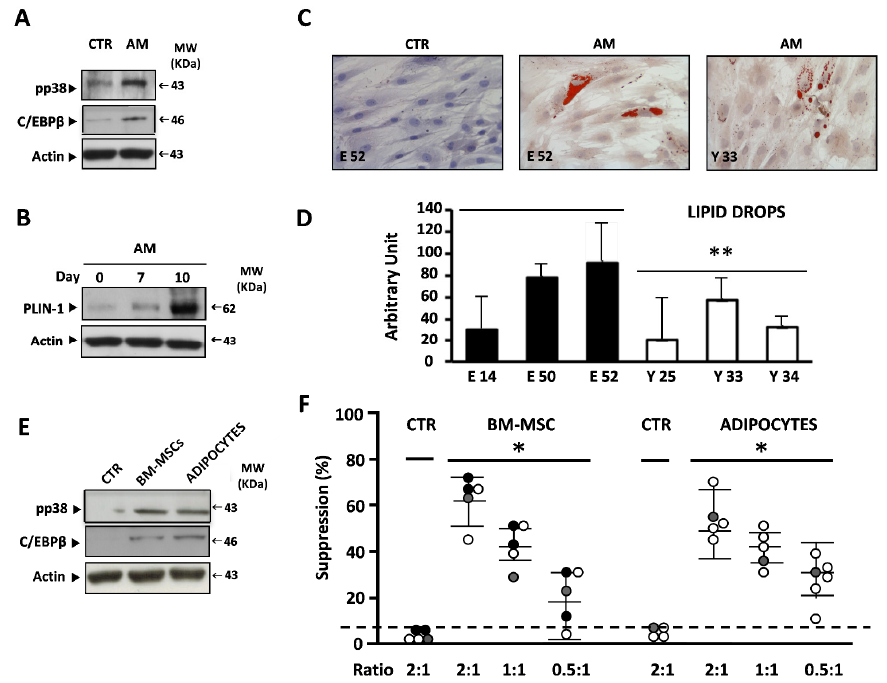
Figure 3. BM-MSCs or BM-MSC-derived adipocytes efficiently induce the suppressive activity of I-MDSCs. ( A ). Representative immunoblotting analysis of p38 MAPK phosphorylation and C/EBP β expression in BM-MSCs treated with adipogenic medium (AM) on Day 3. β -Actin ensured equal loading in the lanes. Arrows indicate relevant bands in all panels. ( B ). Representative immunoblotting analysis with kinetic (Day 0, Day 7, and Day 10) of PLIN-1 accumulation in BM-MSCs during the treatment with AM. β -Actin ensured equal loading in the lanes. Arrows indicate relevant bands in all panels. ( C ). Representative morphology of BM-MSCs and BM-MSC-derived adipocytes from both young people (Y33) and elders (E52), stained with red oil, after 10 days of treatment with AM. ( D ). Diagrams of pixel quantification of lipid drops content, relative to images in Figure 3C, generated with ImageJ (http://imagej.nih.gov/ij/, 1997–2011, accessed on 21 December 2021), in BM-MSC cultures from young or elder donors, treated with AM. Values are the mean ± SD of area pixels obtained in at least three independent experiments. ( E ). Representative immunoblotting analysis of p38 MAPK phosphorylation and C/EBP β expression in I-MDSCs co-cultured with either BM-MSCs or BM-MSC-derived adipocytes on Day 4. β -Actin ensured equal loading in the lanes. Arrows indicate relevant bands in all panels. ( F ). Percentage of suppression of the proliferation of heterologous PBMCs by I-MDSCs co-cultured in presence of BM-MSCs (left) or adipocytes derived from BM-MSCs (right). Dots represent the mean of co-cultures performed in duplicate. * p < 0.05, ** p <